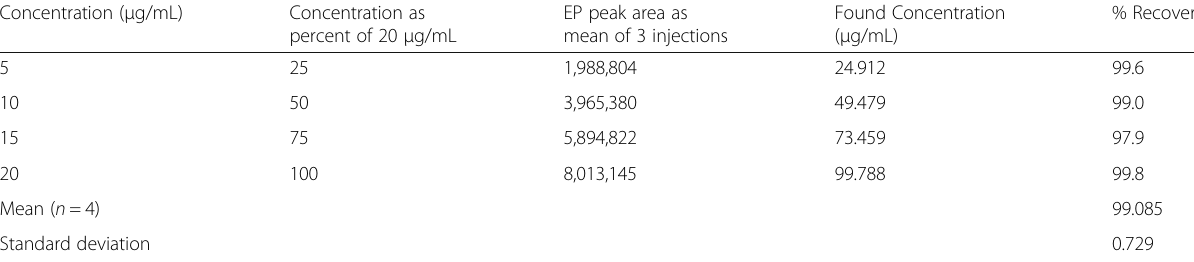
Table 1 Results of assessment of linearity of TLC-FID method for assay of chlorpyrifos Concentration ( μ